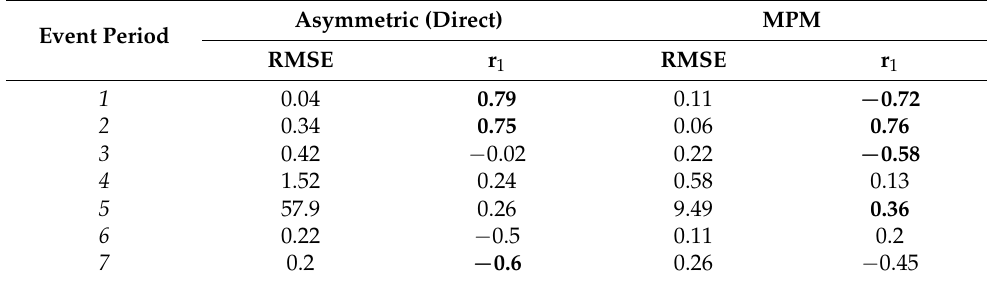
Table 5. Event-based cumulative error (RMSE) and correlation coefficient (r 1 ) between the calculated transports (both asymmetric direct and MPM) and the sonar estimates. Significant correlations ( p < 0.05) are indicated in bold.